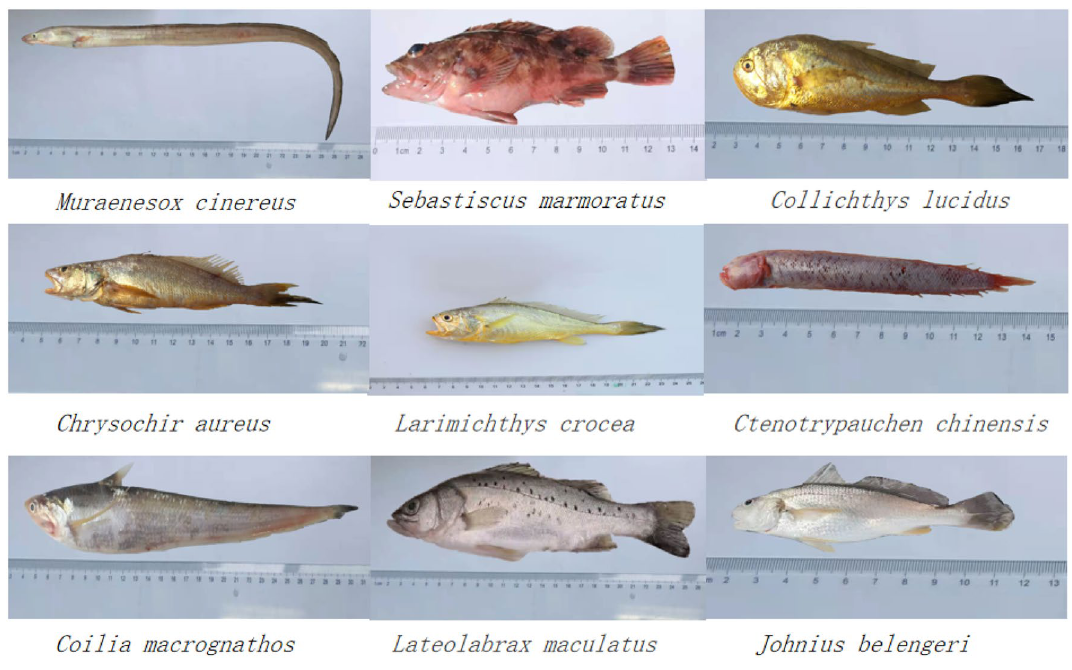
Figure 2. The experimental fish samples collected from Dachen fishing ground, East China Sea.